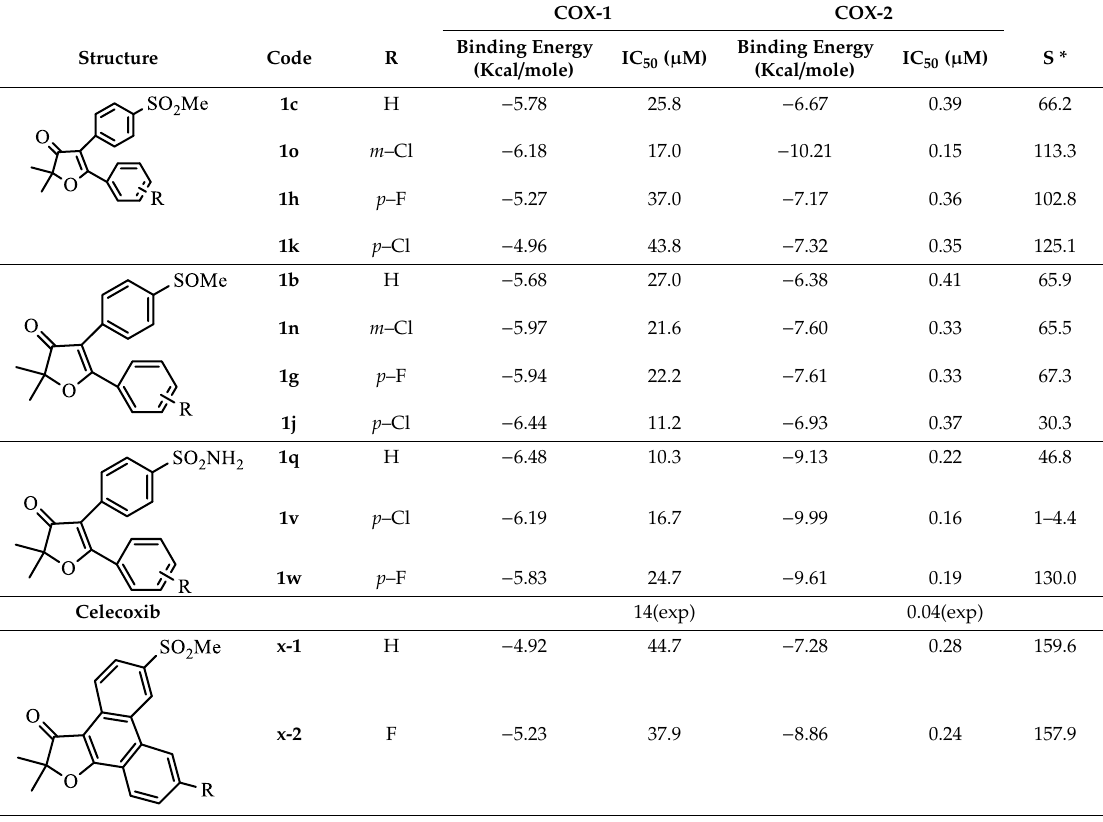
Table 1. Predicted IC 50 values of the designed compounds.